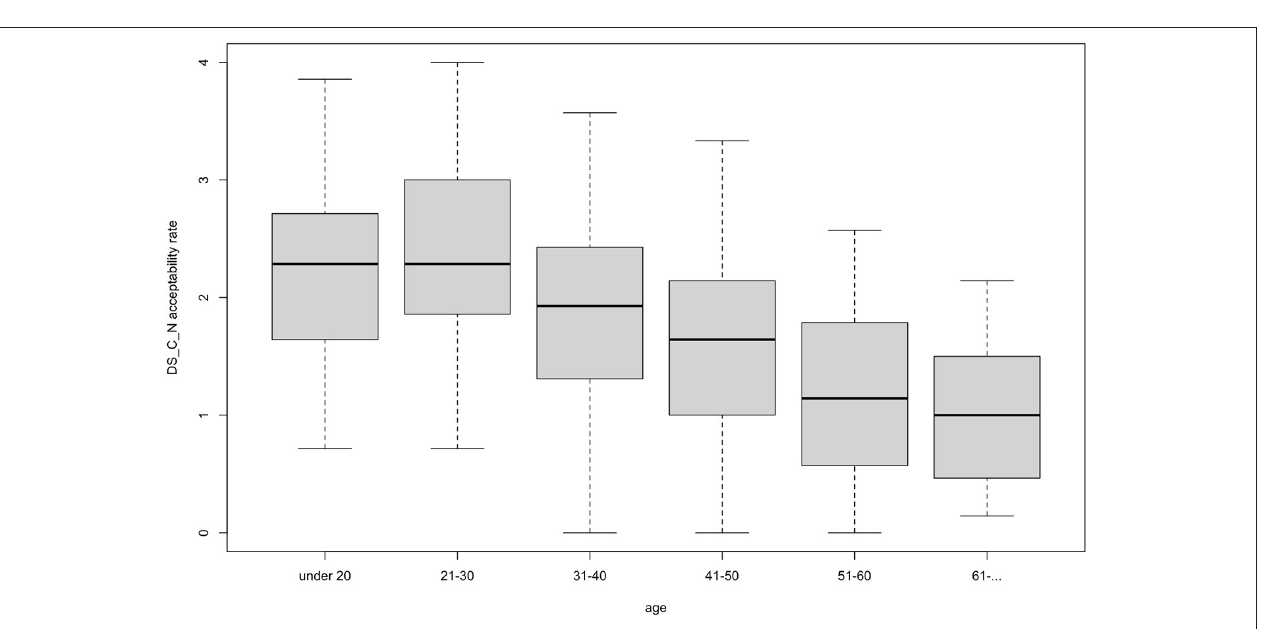
FIGURE 4 | Acceptability rate of basic -type adjectives in the non-agreement condition by